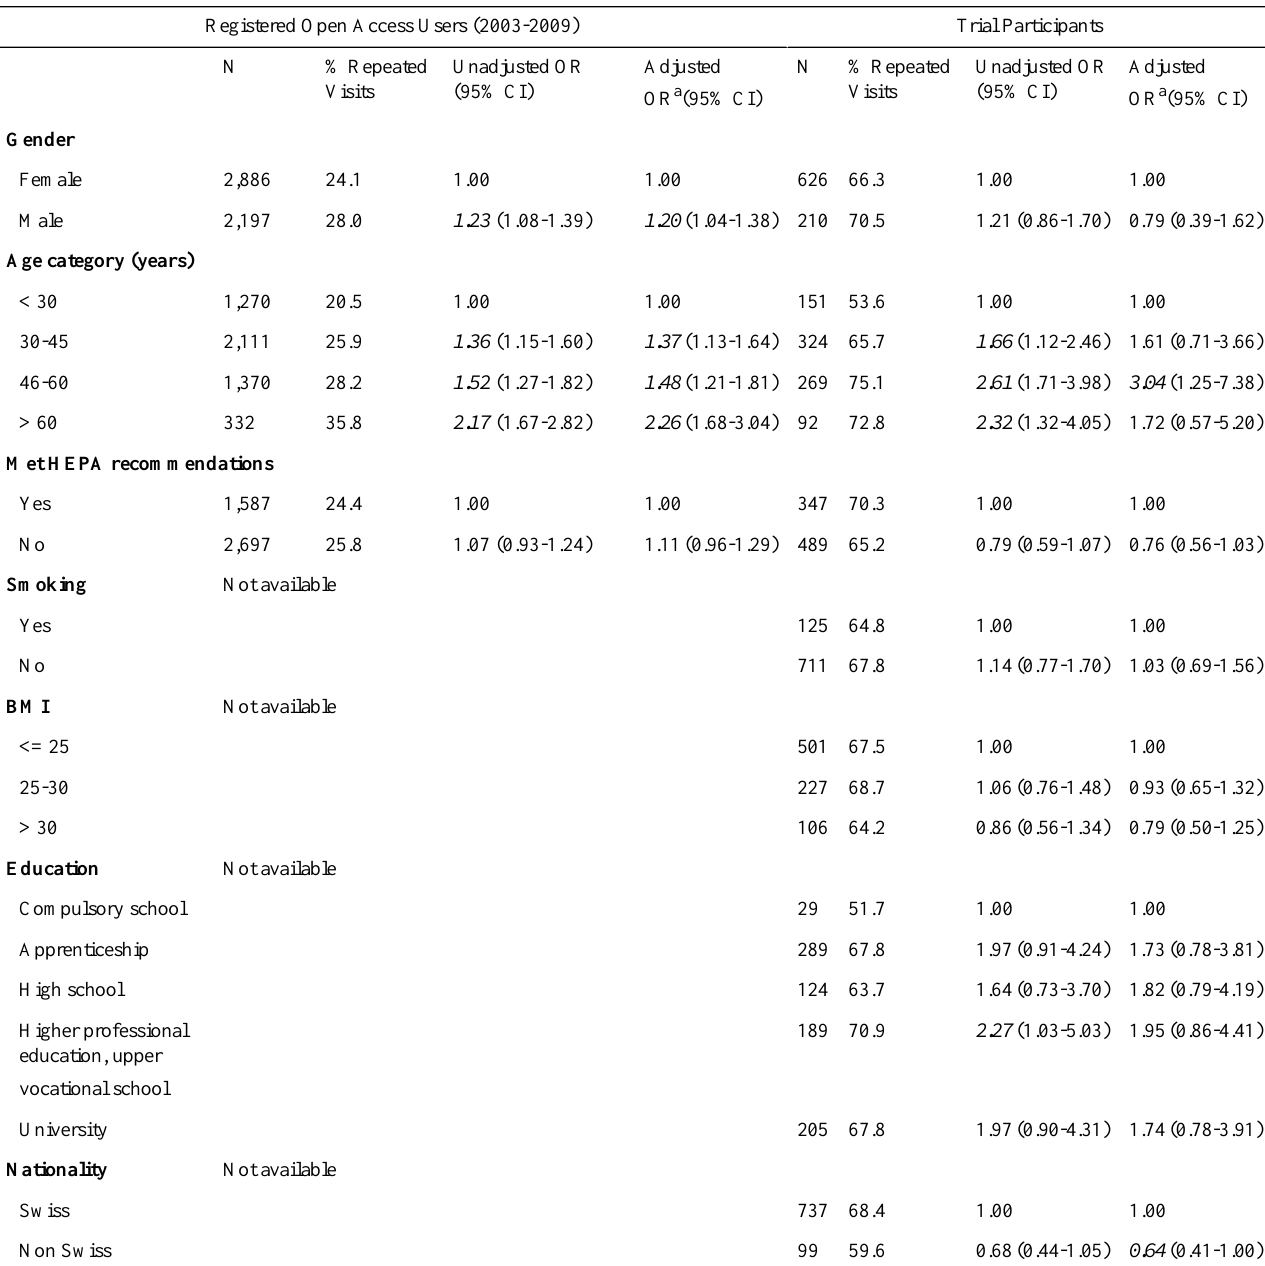
Table 3. Predictors of repeated participation for registered open access users and for trial participants